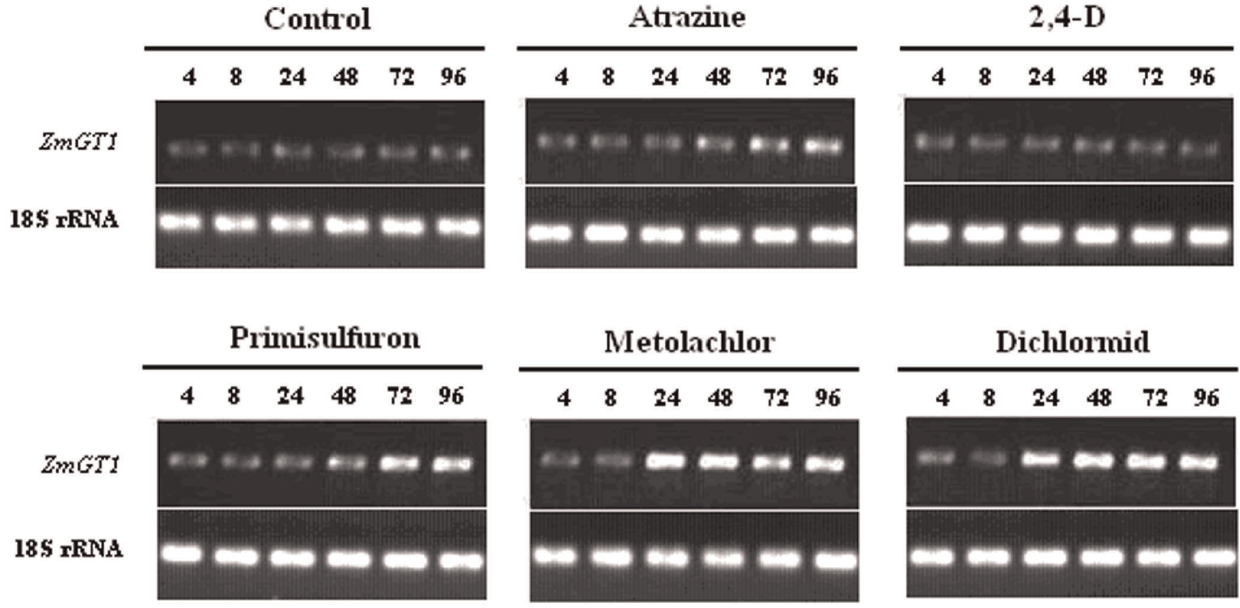
Figure 3. Semi-quantitative RT-PCR analysis of ZmGT1 expression in maize leaves after treatment by various chemicals. The numbers (4, 8, 24, 48, 72 and 96) above each lane indicate the time intervals (h) after treatment. The experiment was repeated twice with similar results.